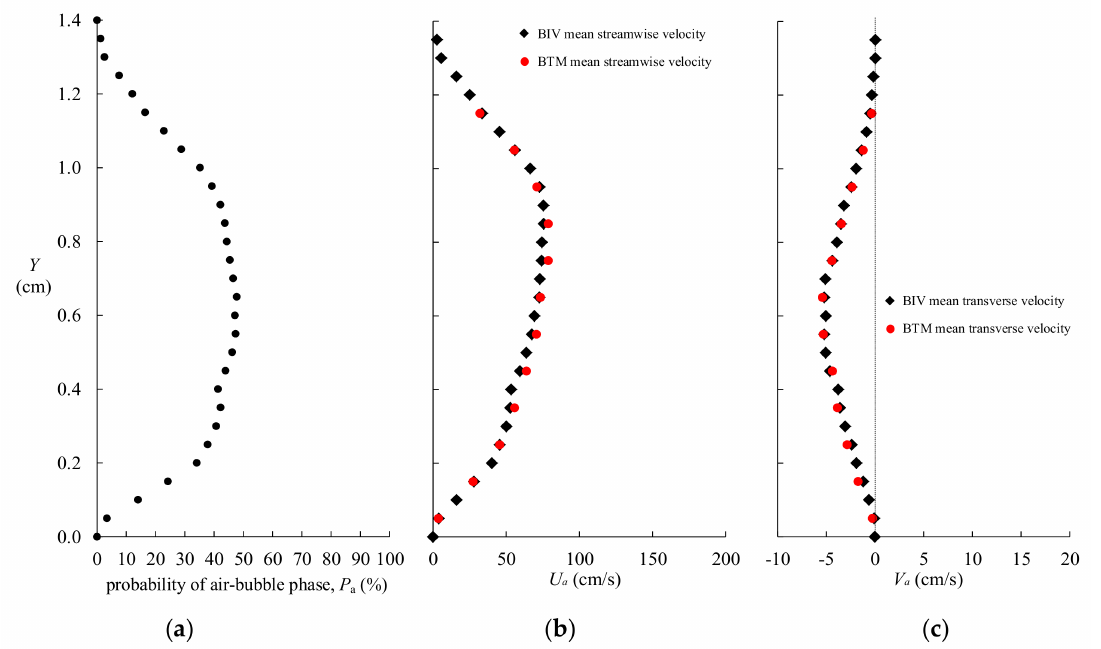
Figure 18. ( a ) Probability distribution for intermittent occurrence of air bubbles at X = 17.0 cm; ( b , c ) comparison of the mean streamwise/transverse velocity profile of air bubbles determined by BTM with that obtained by BIV